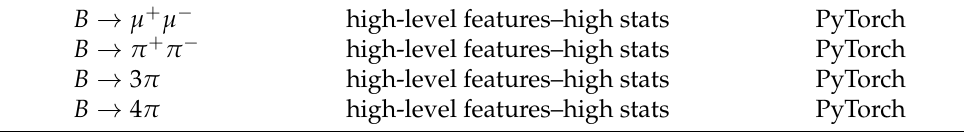
Table 10. Best training option for the data and library for each